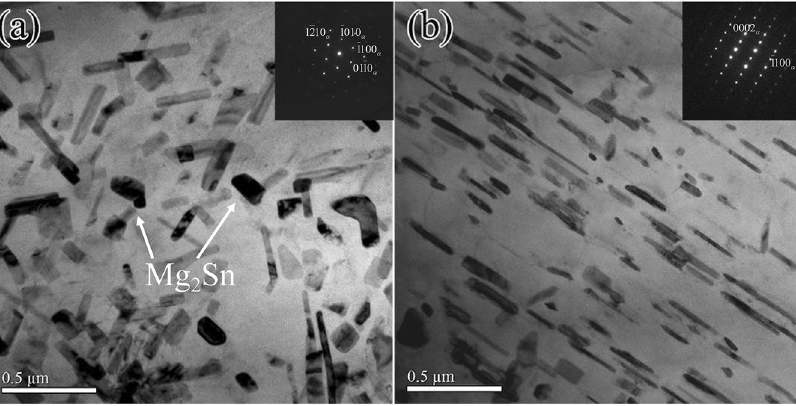
Figure 10. Bright-field TEM images of Mg-3Sn alloys in the ( a ) [0001] and ( b ) [1120] direction of α -Mg.